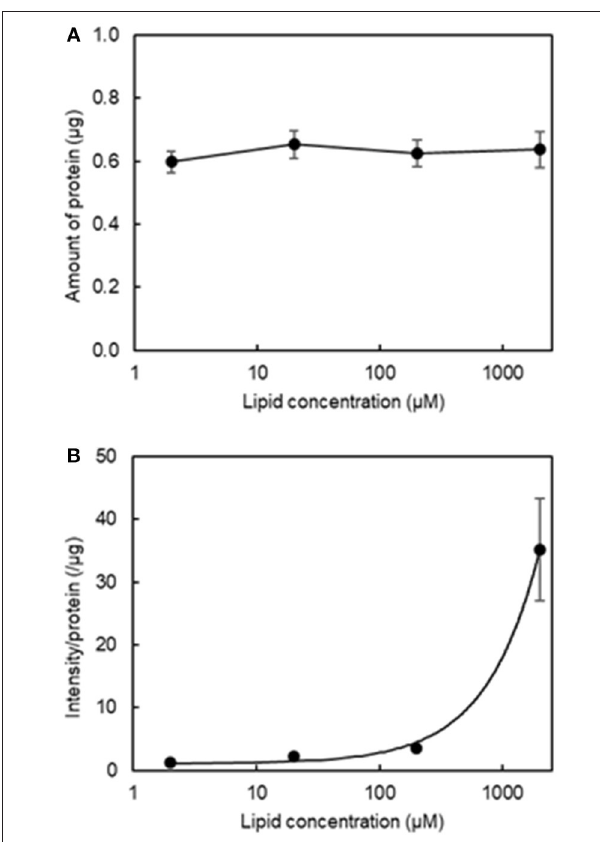
FIGURE 3 | Effect of final lipid concentration on the amount of protein and fluorescence intensity in the aggregation of H12-L551 liposomes with activated platelets ( n = 1). (A) Mean amount of protein at various final lipid concentrations between 2 µ M to 2000 µ M after washing four times. (B) Relationship curve of lipid concentration to mean fluorescence intensity per protein after washing four times. Error bars indicate SD of three determinations.